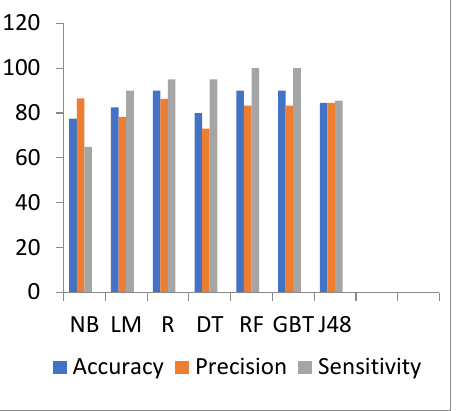
Figure 4. Accuracy, precision, and sensitivity comparison of different algorithms on heart disease preprocessed data.